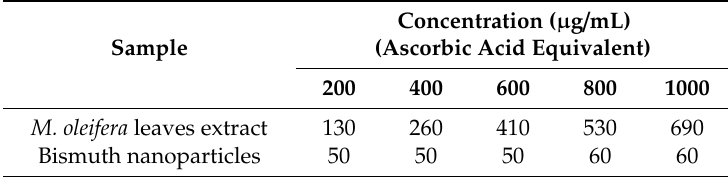
Table 4. Total antioxidant capacity (TAC) using phosphomolybdate assay.